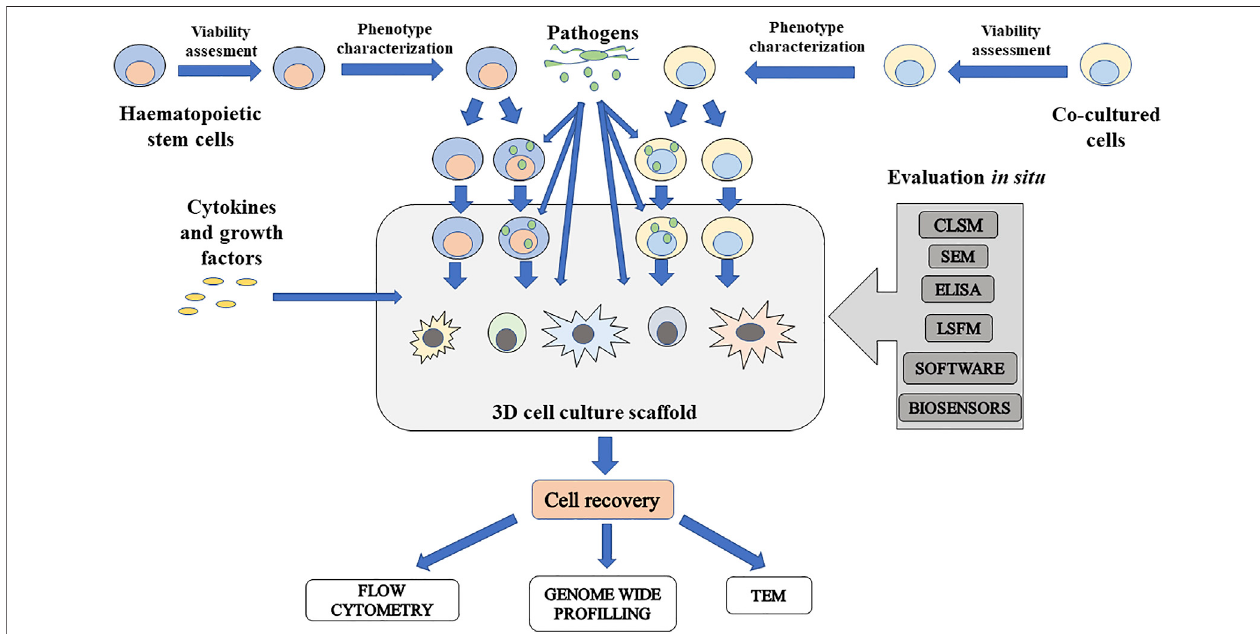
FIGURE 4 | Schematic presentation of scaffold-based 3D cell culture to study in fl uence of pathogens on hematopoiesis. Isolated hematopoietic stem cells (HSC) and cocultured cells can be infected before insertion to culture or after culturing in 3D culture. To study differentiation potential of infected HSC, cytokines and growth factors can be added and can initiate differentiation in various immune cells. At the same time, pathogens can be included to study how these disease causative agents candisruptdifferentiationinimmunecells.For insitu evaluation,therearesomeusabletechniques.Imagingtechniquesincludeconfocallaserscanningmicroscopy (CLSM), scanning electron microscopy (SEM), and light sheet fl uorescence microscopy (LSFM). Content of molecules released by infected cells can be measured by standard ELISA method. Software-based techniques such as FluoroCellTrack can be used for evaluation of cells in fl ow, in micro fl uidic systems, or embedded cells in a scaffold. For monitoring of culture conditions, microchips for electrochemical detection of important measurable parameters such as oxygen, carbon dioxide, nutrients, and metabolite levels can be included. If it is possible to recover cells from the cultured scaffold, cells can be evaluated by antibody-based techniques, genome-wide pro fi ling, and microscopy techniques such as transmission electron microscopy (TEM) for intracellular structure imaging.